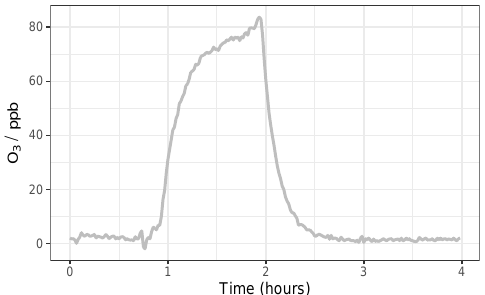
Figure 5. Example O 3 spike from the MOx Laboratory